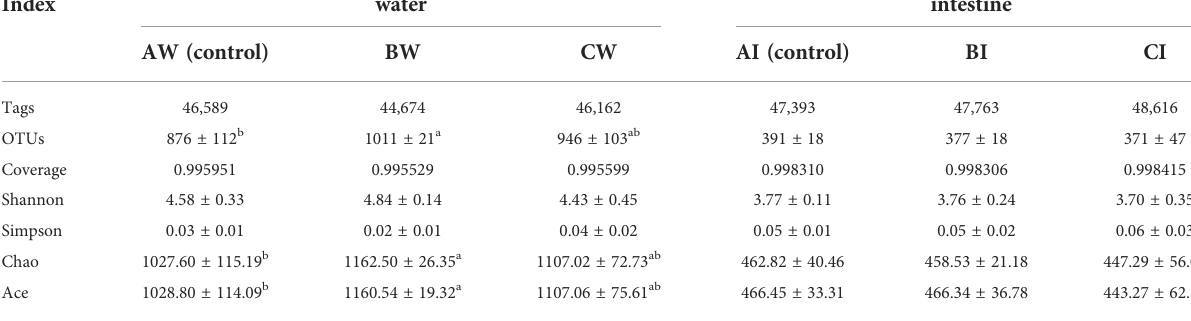
TABLE 2 OTU, diversity index and estimated OTU richness for the intestinal and water bacterial diversity analysis of L. vannamei with sodium humate (BI, BW) and sodium humate with probiotics (CI,